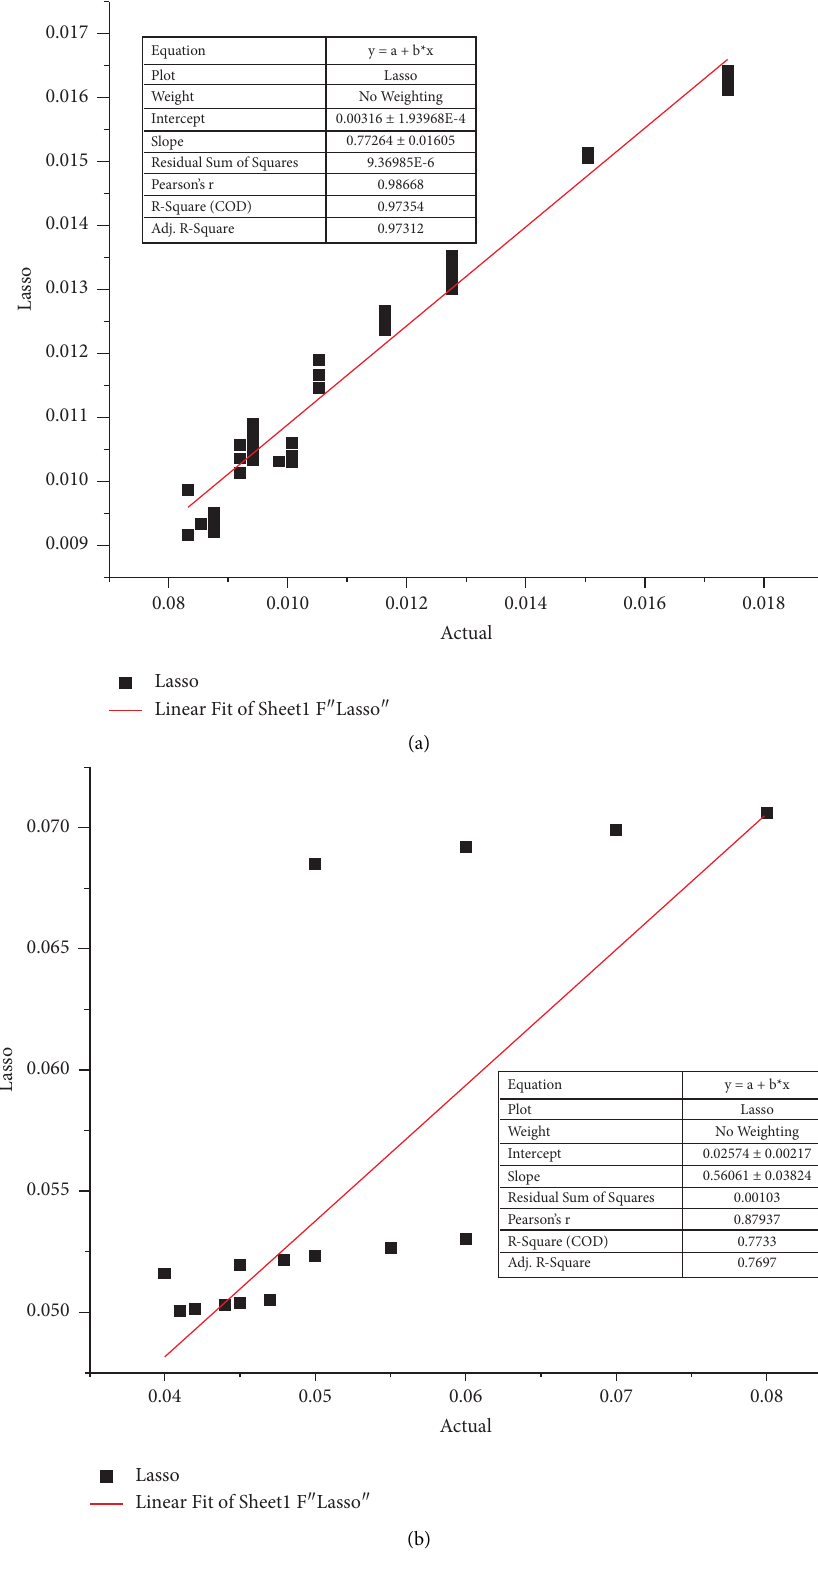
Figure 11: Te Lasso model scatter plots for the testing phase of the gas fow: (a) fracture porosity in oil system and (b) fracture